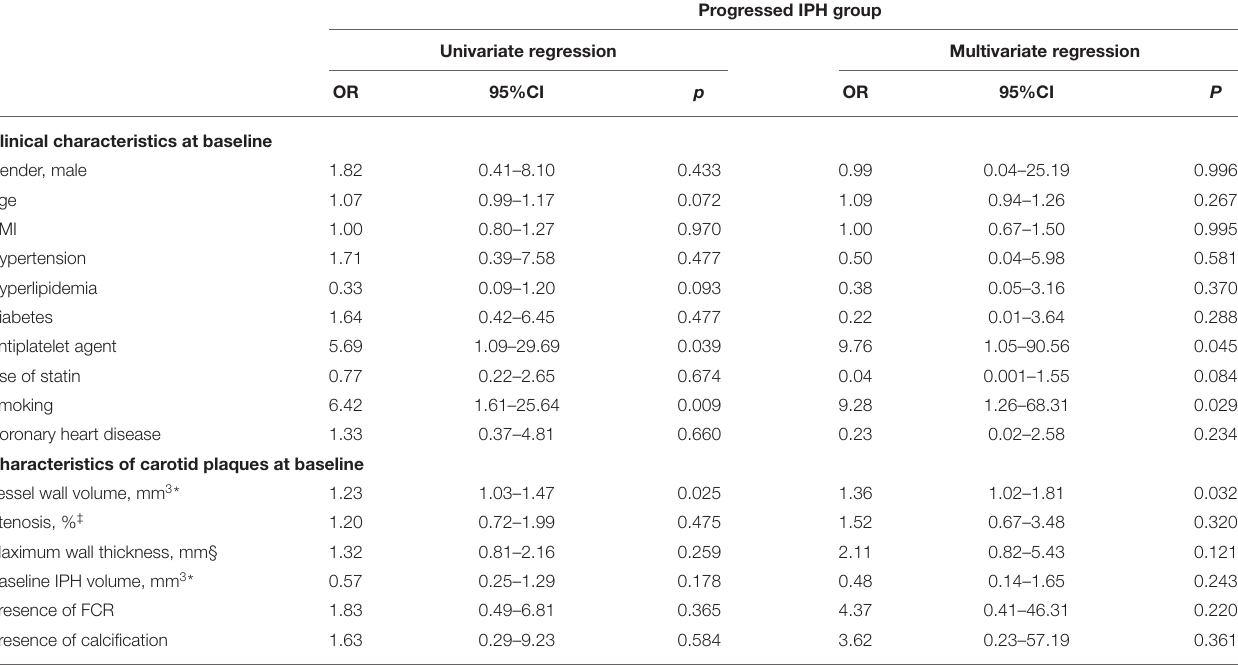
TABLE 3 | Logistic regression models of risk factors for the progressed IPH